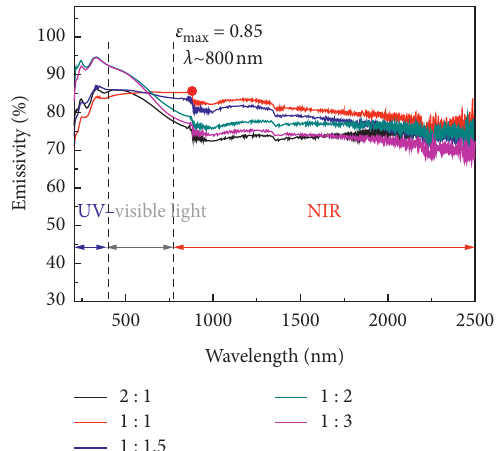
Figure 5: UV-vis emissivity spectra of all samples.